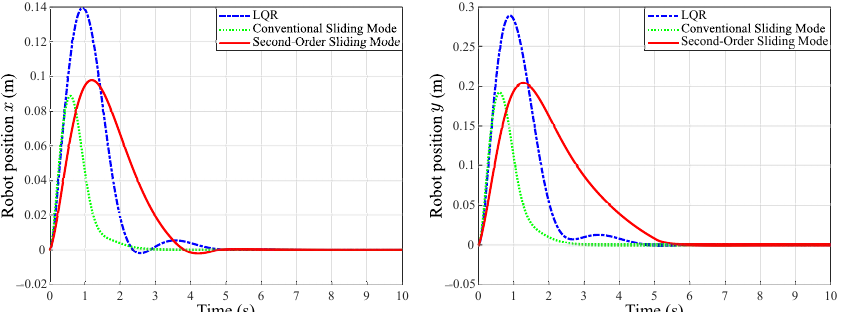
Figure 12. The simulation results of the spherical inverted pendulum compare the robot’s position responses on the X -axis and Y -axis, respectively.